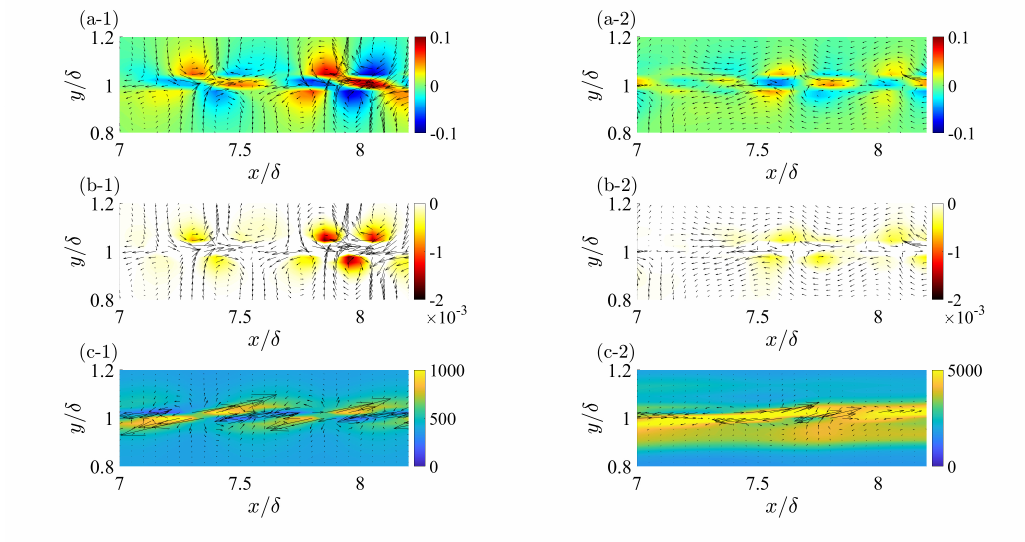
Figure 13. ( a ) Decomposed velocity field and corresponding elastic force field by the polymeric stress tensor for (–1) Re = 10 and Wi = 20 and (–2) Re = 100 and Wi = 100. Vector: ( a , b ) ( u s ∗ , v s ∗ ), ( c ) ( ∂τ (cid:48) / ∂ x j , ∂τ (cid:48) / ∂ x j ). Contour: ( a ) ω s ∗ z = ∂ v s ∗ / ∂ x ∗ − ∂ u s ∗ / ∂ y ∗ . ( b ) Second invariant of deformation xj yj tensor Q s based on the small-scale components, and ( c ) tr ( c ij ) .